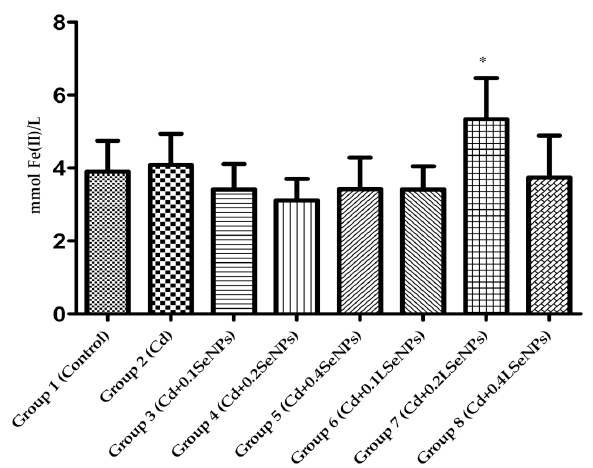
Figure 4. FRAP values of blood mice after 30 days treatments. All values were expressed as mean ± SD for 10 mice in each group. * p < 0.05 is statistically significant difference of sample vs. control group. Groups: 1—control; 2—CdCl 2 ; 3—CdCl 2 + 0.1 mg/kg SeNPs; 4—CdCl 2 + 0.2 mg/kg SeNPs; 5—CdCl 2 + 0.4 mg/kg SeNPs; 6—CdCl 2 + 0.1 mg/kg LSeNPs; 7—CdCl 2 + 0.2 mg/kg LSeNPs; 8—CdCl 2 + 0.4 mg/kg